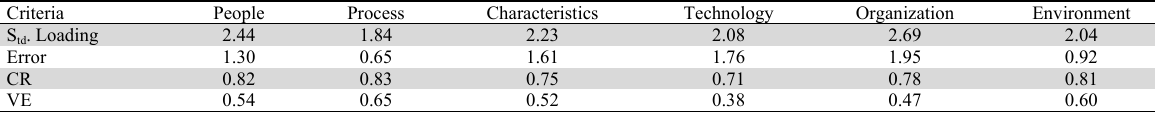
Construct reliability (CR) and variance extracted (VE) of people, process, characteristic, technology, organization, and